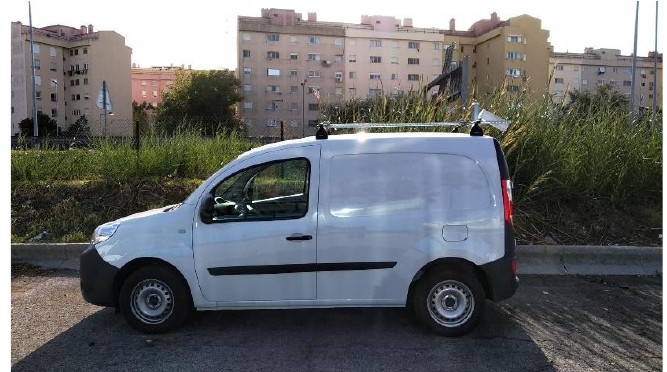
Figure 5. Image acquisition system consisting of a conventional 2D camera mounted on the back of a vehicle.